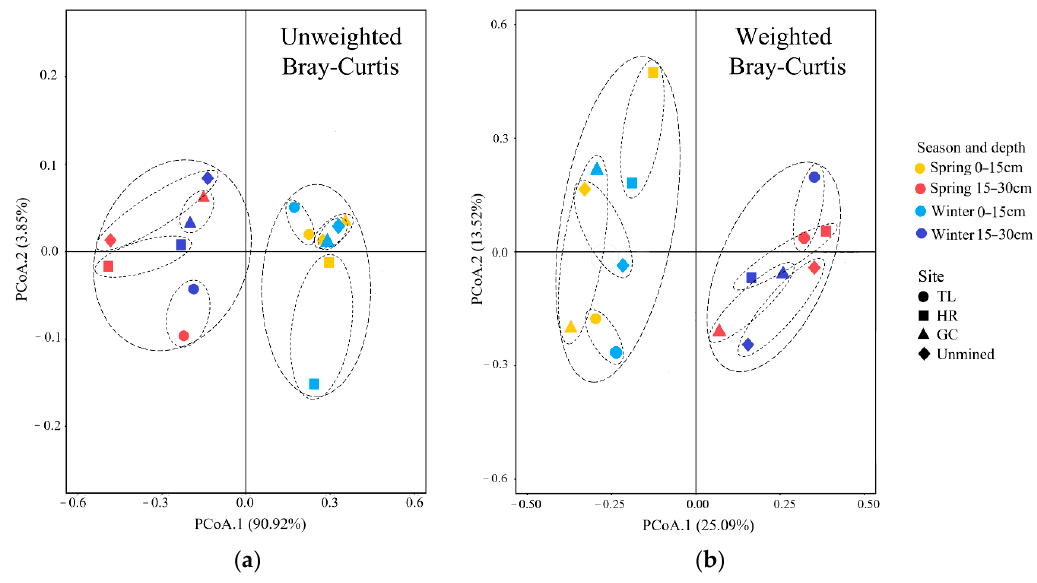
Figure 5. Principal coordinate analysises (PCoA) of the unweighted ( a ) and weighted ( b ) Bray-Curtis dissimilarity among AMF communities. Pair-wise post hoc comparisons for four sites are presented in Table S1. Int. J. Environ. Res. Public Health 2020 , 17 , x